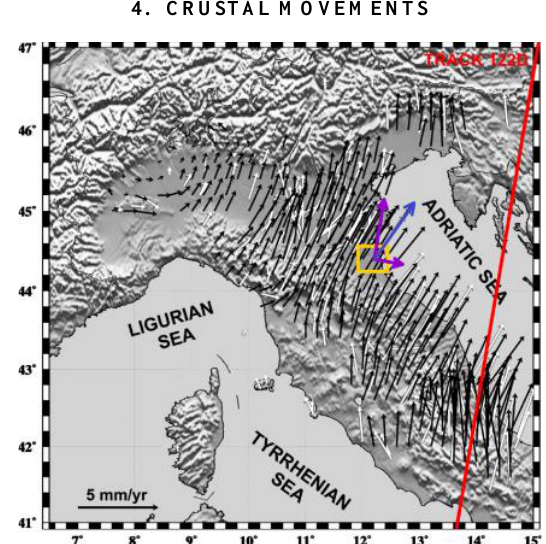
Figure 3. Velocity field in the northern Italy (modified by Baldi et al.,